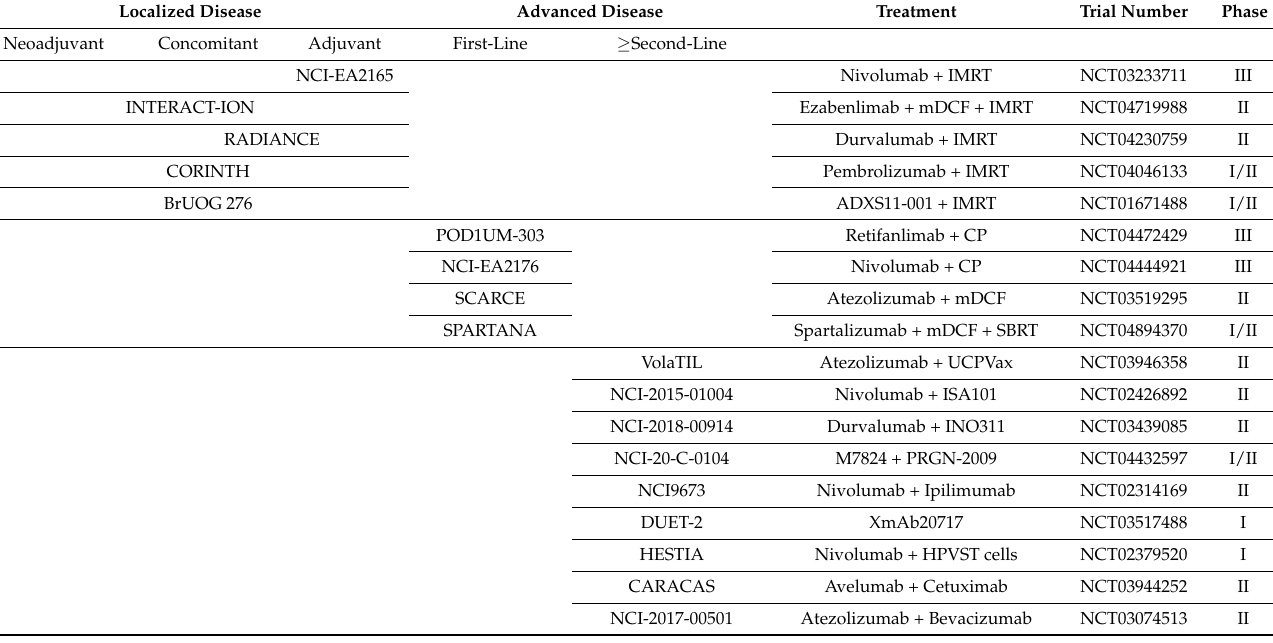
Table 1. Immunotherapy combination clinical